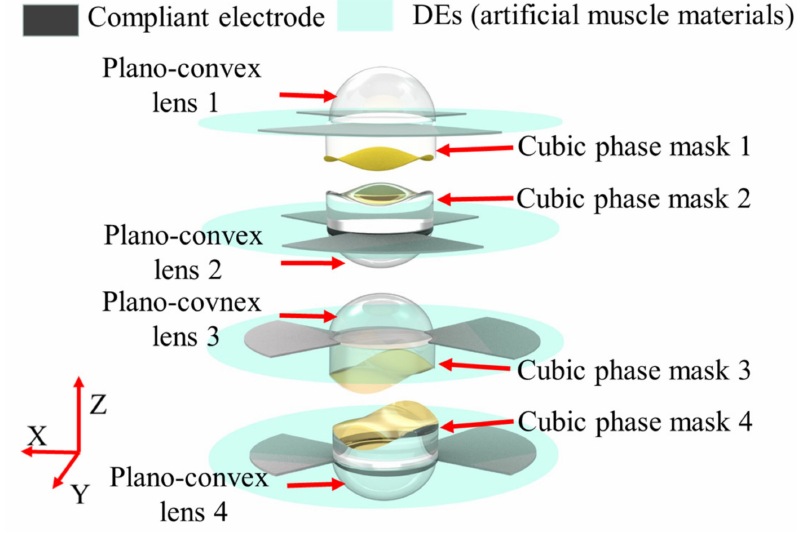
Figure 1. The architecture of the proposed two-dimensional varifocal scanning